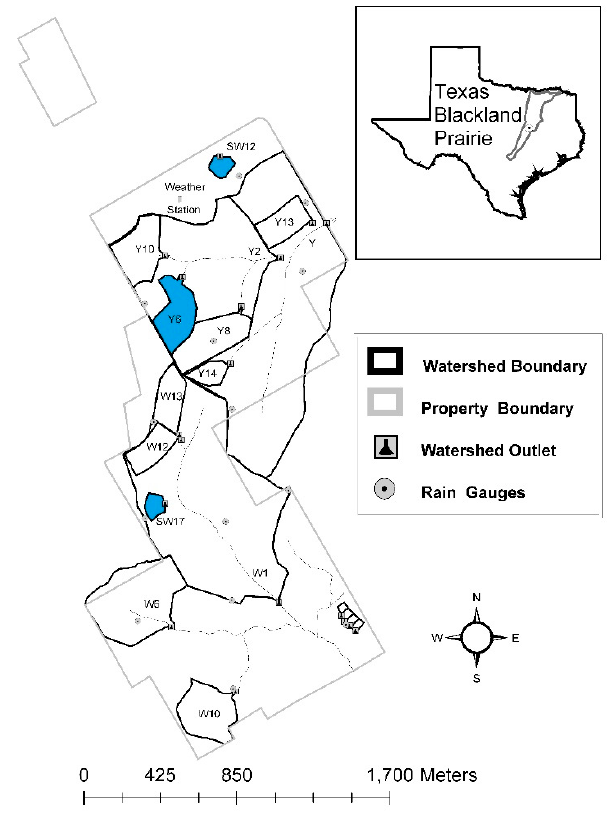
Figure 1. Map of study site near Riesel, TX (USA) with watersheds native prairie (SW12), improved pasture (SW17), and cultivated cropland (Y6) highlighted in blue.